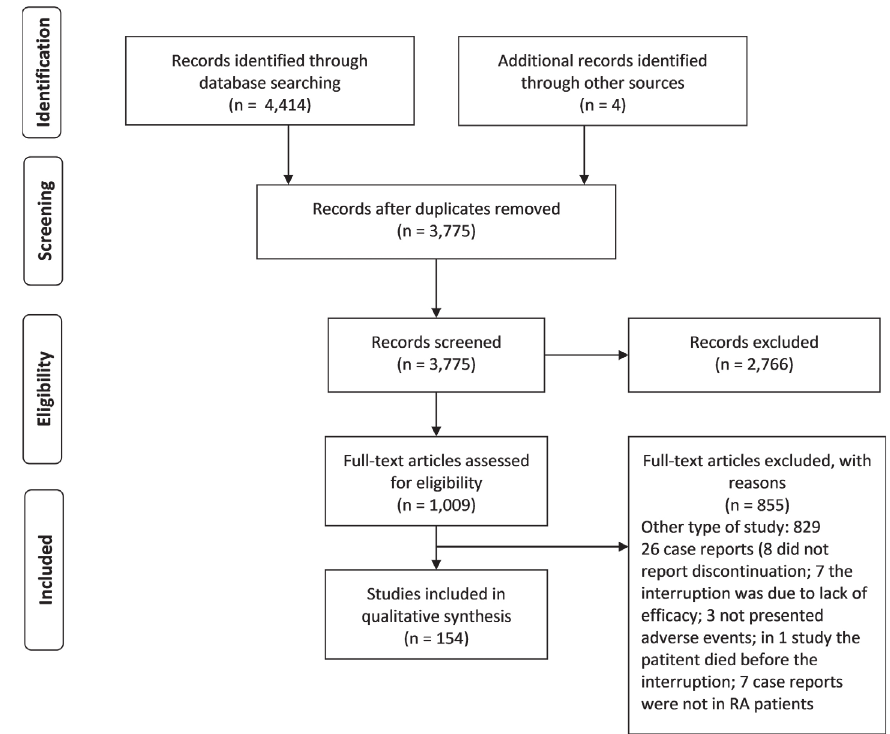
FIGURE 1 - Flowchart of study